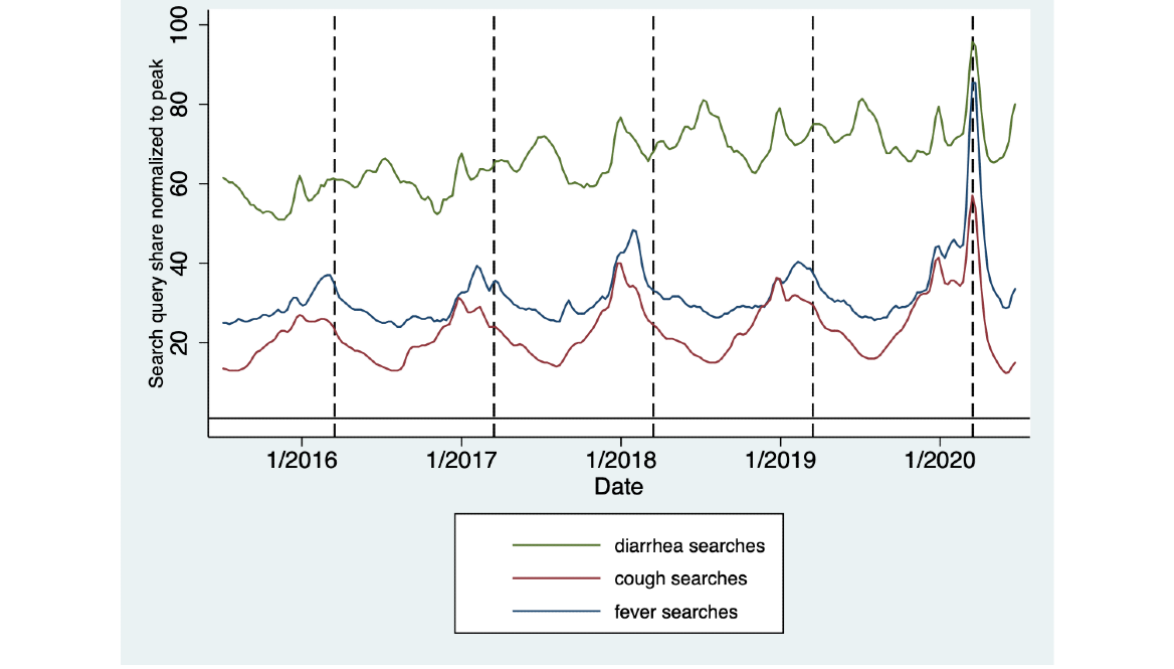
Figure 2. Seasonal trends in Google search query shares for fever , cough , and diarrhea over the last five years as percentages of peak